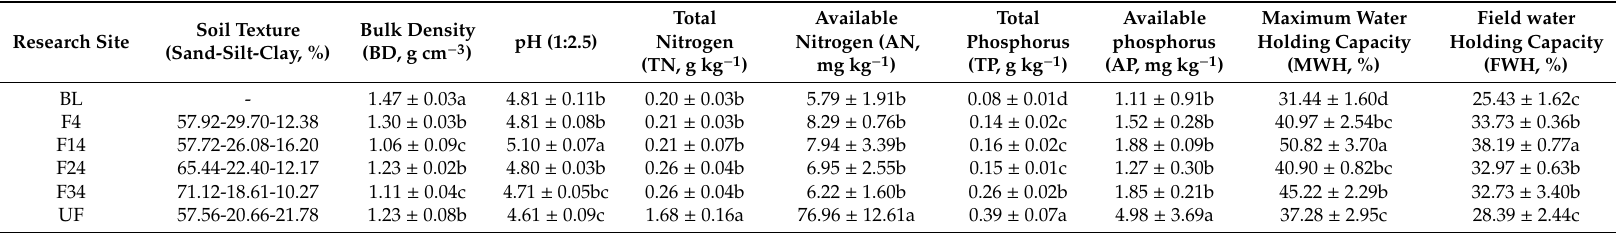
Table 2. Soil physical and chemical characteristics of the surface soils (0–20 cm) among six research sites. Note: Data are mean ± SD, n = 3; Di ff erent letters